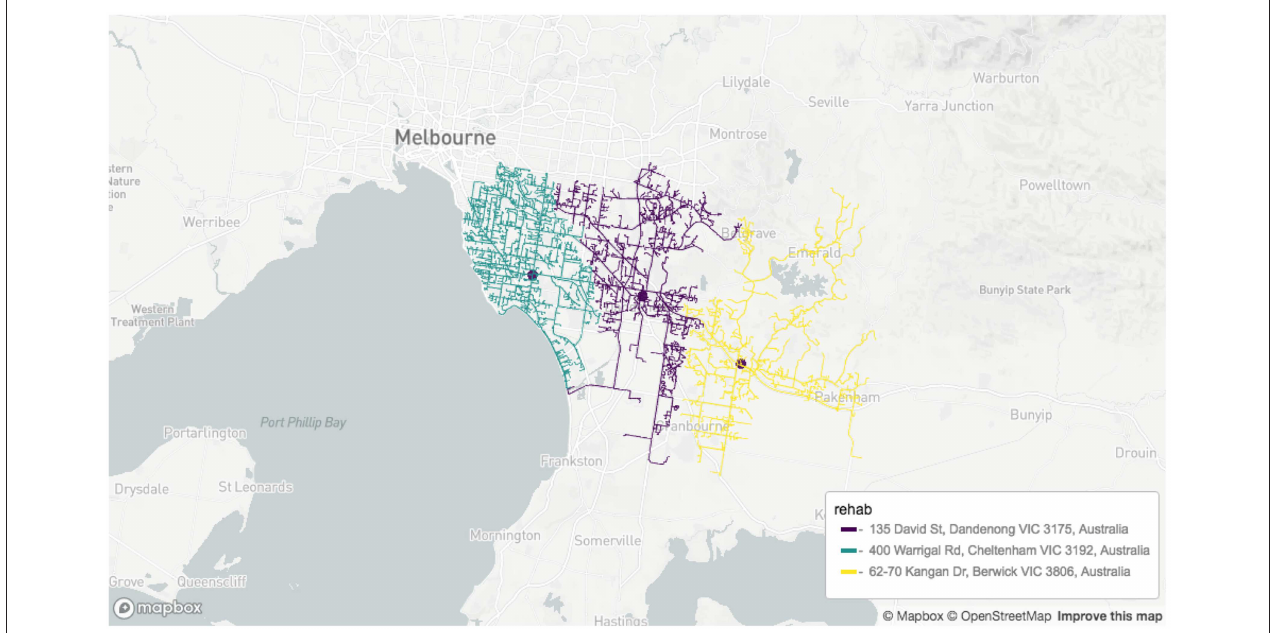
FIGURE 8 | Road network-based visualization of catchment zones for rehabilitation centers. Screenshot of interactive visualization created with mapdeck (API key required).